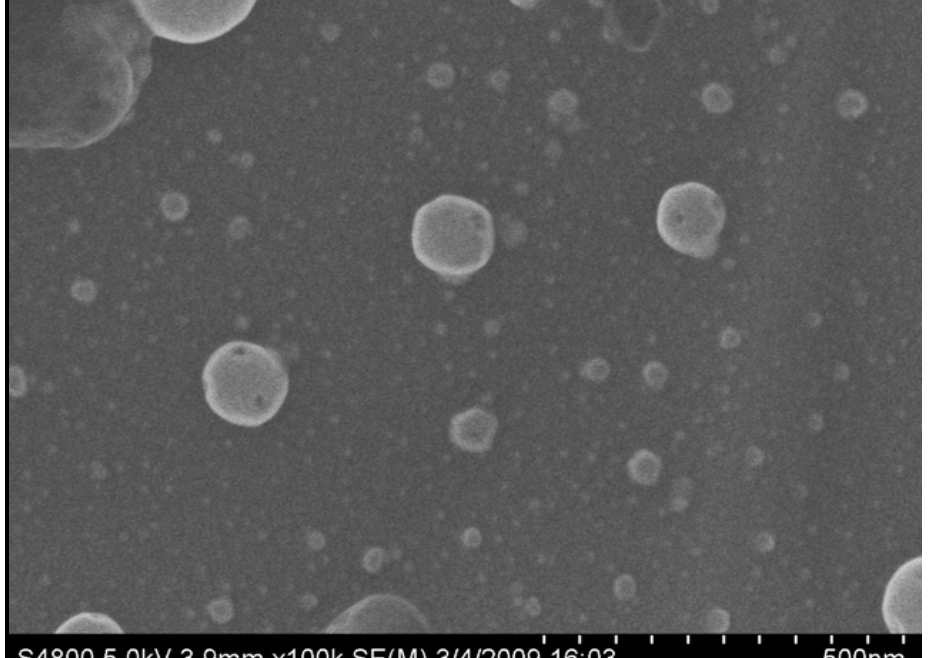
O samples: ( a ) Hollow ball; ( b ) Solid 2 3